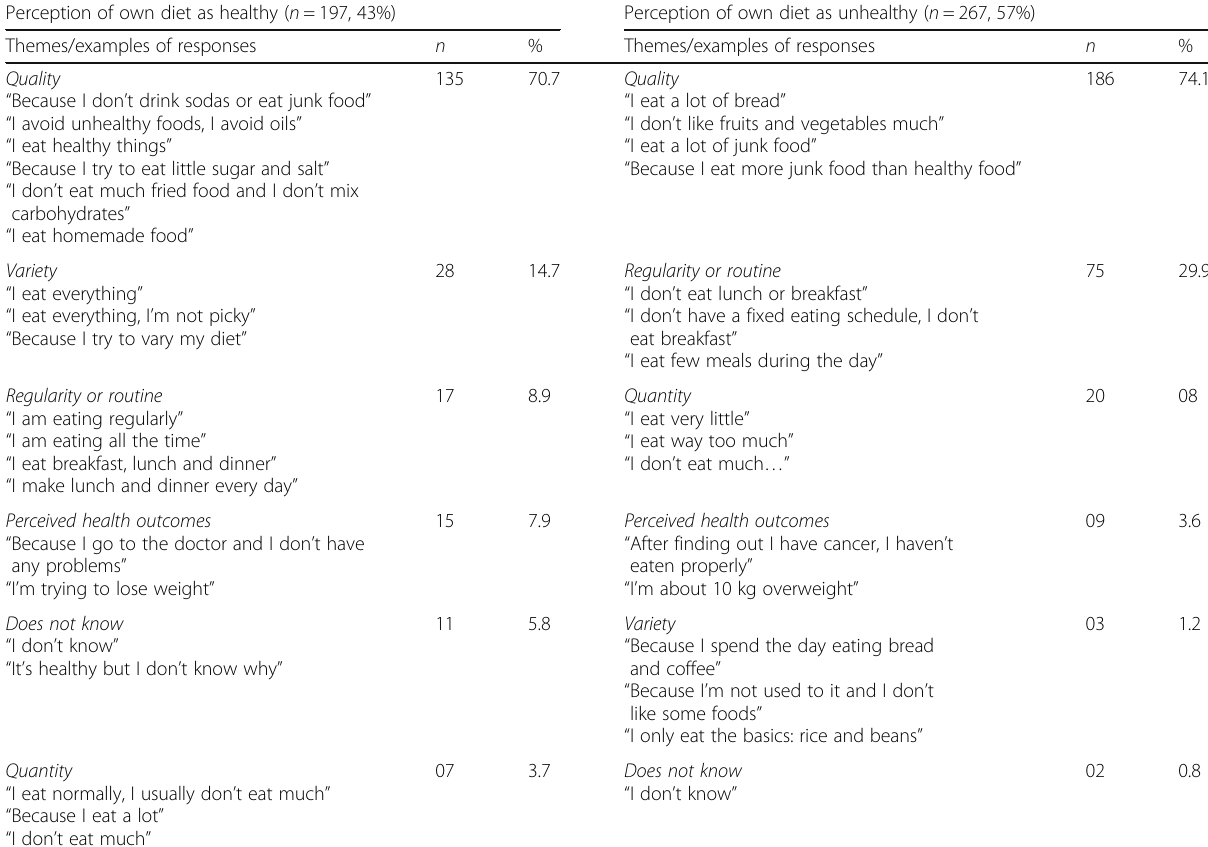
Table 1 Categorization and distribution of responses regarding mothers ’ perceptions of their own diets ( n = 464) Perception of own diet as healthy ( n = 197,